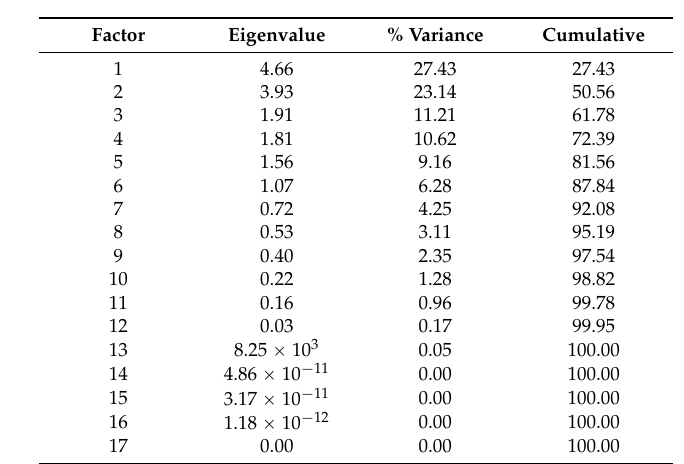
Table 4. Eigenvalues, percent of explained variance of each factor and cumulative percentage of variance explained.